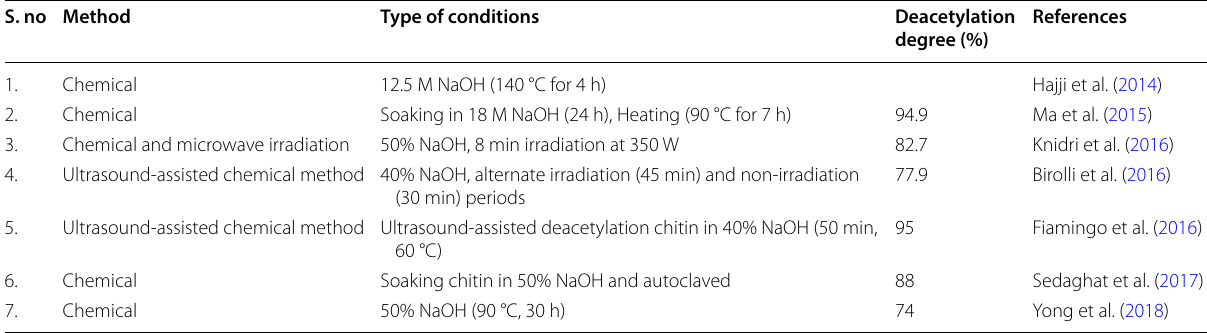
The physiochemical properties of chitin and chitosan have been summarized in Table 4